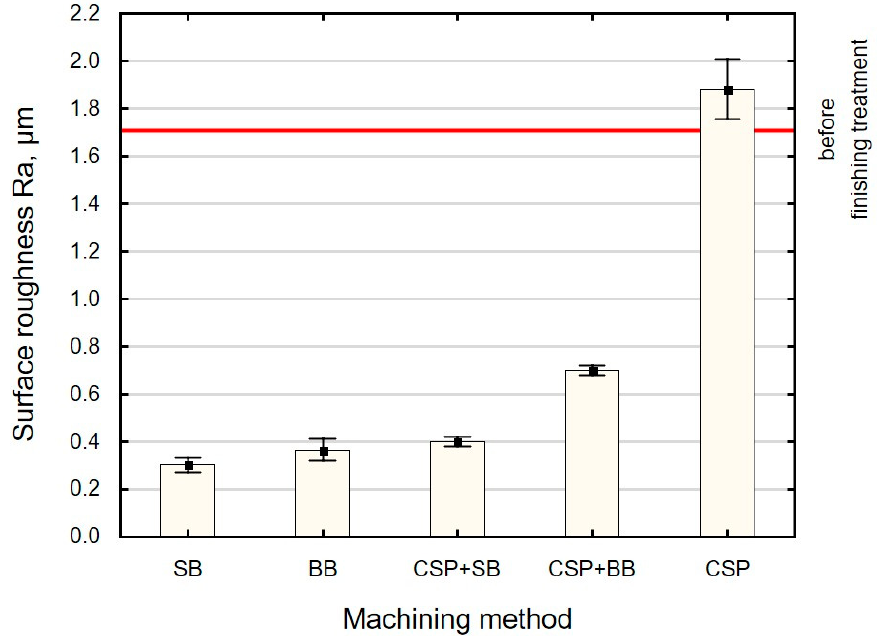
Figure 6. Effect of the finishing method on the surface roughness parameter Ra (SB—slide burnishing, BB—ball burnishing, CSP + SB—centrifugal shot peening + slide burnishing, CSP + BB— centrifugal shot peening + ball burnishing, CSP—centrifugal shot peening).